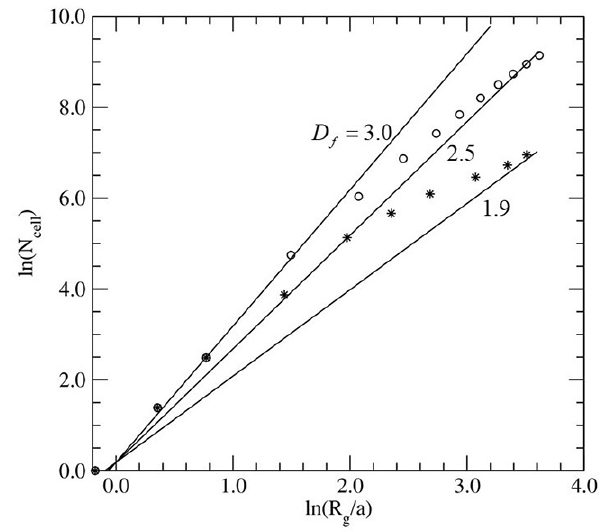
Figure 2. Relationship between the number of cells N cell assuming N cell = N , from Eq. (1), and normalized gyration radius R g /a for the modeled soot aggregates. Asterisks and open circles correspond to Type A and Type B aggregates, respectively. Solid lines represent the relationship described by Eq. (1) for fractal dimensions of D f = 1 . 9 , 2 . 5 , 3 . 0 when k 0 = 1 .